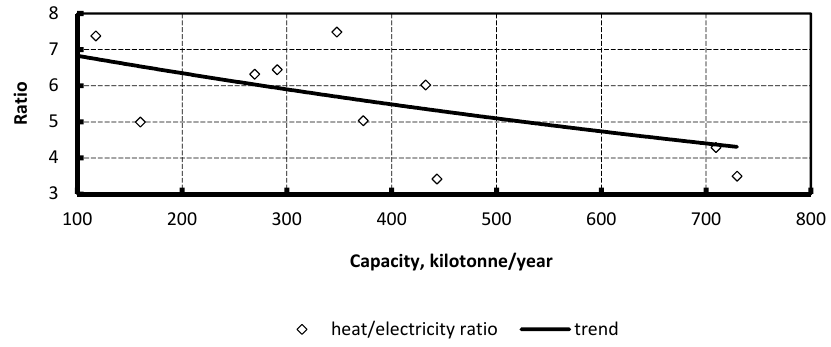
Figure 4. Heat / electricity consumption ratio vs. sunflower oil refinery Figure 4. Heat/electricity consumption ratio vs. sunflower oil refinery capacity.